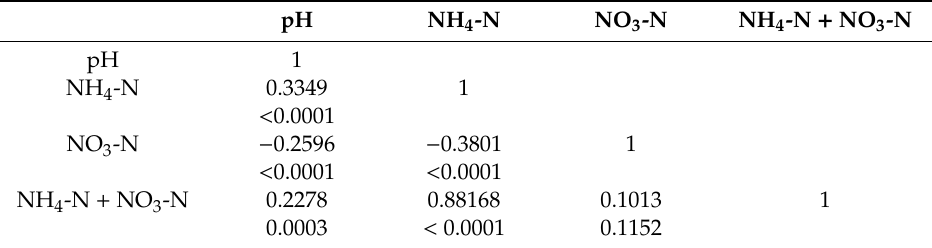
Table 5. Correlation coe ffi cients for soil parameters in the incubation